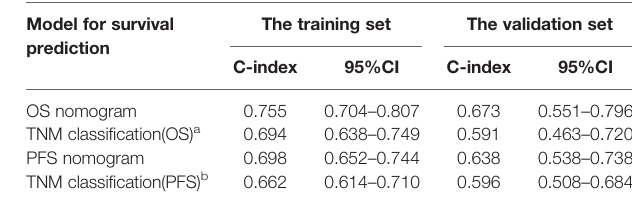
TABLE 3 | The C-index of nomograms for OS and PFS in the training set and validation